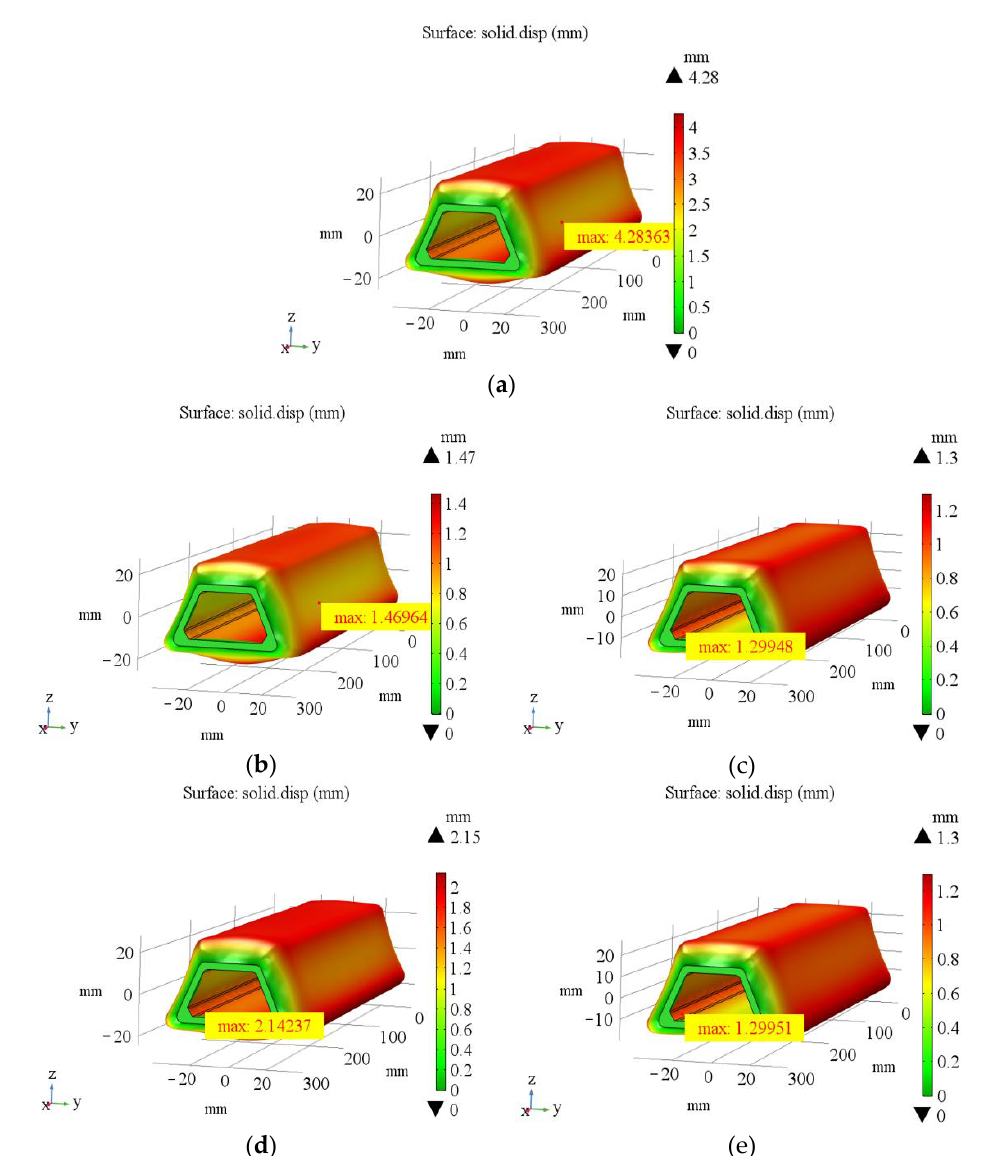
Figure 10. Thermal deformation of five bladders without considering uneven pressure.